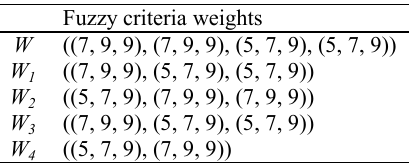
Table 7. Weighting vectors for the criteria and sub-criteria.